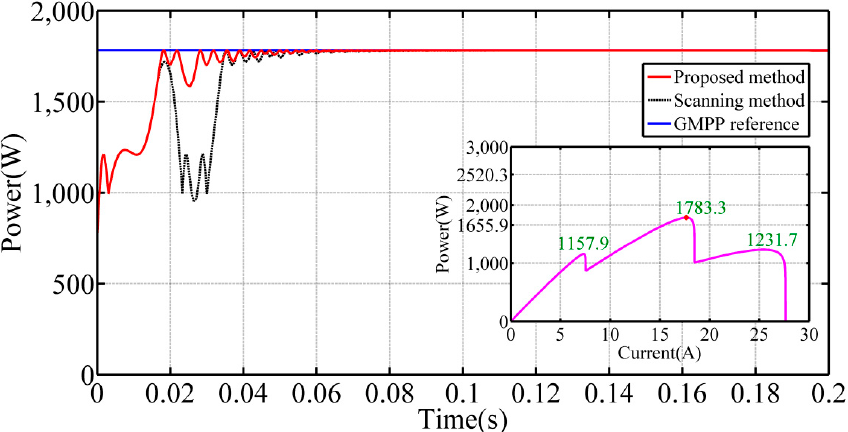
Figure 11. The GMPPT trajectories with three peaks for scanning method and OIV-INC algorithm under stationary shade condition, with the corresponding P-I characteristic curve.